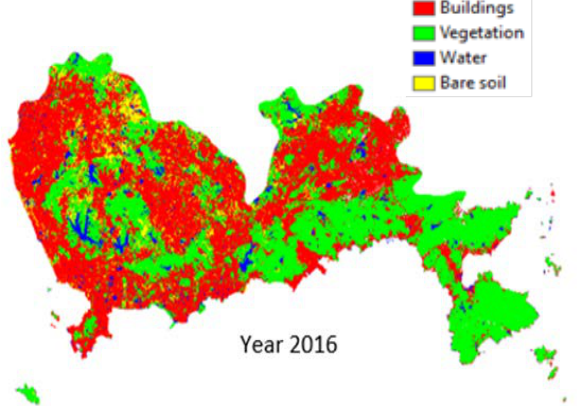
Figure 3: Maps showing pattern of land changes due to urbanization of Shenzhen city